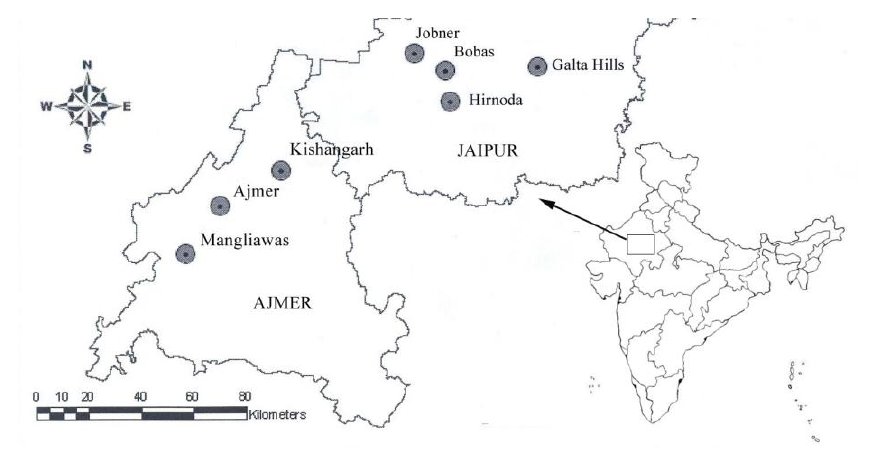
Figure 1. Location of the seven populations of C. wightii included in the study from the state of Rajasthan,